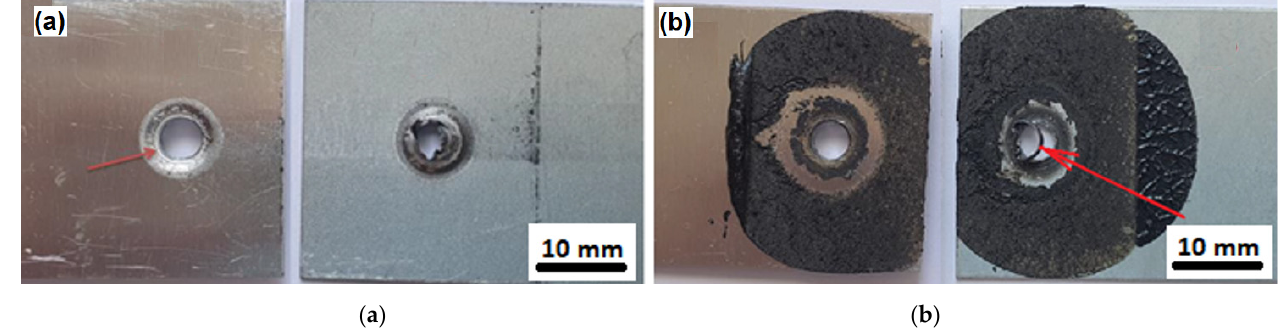
Figure 6. Fracture surface of TL-Al joint made by ( a ) FD, ( b ) FD + AB technology.